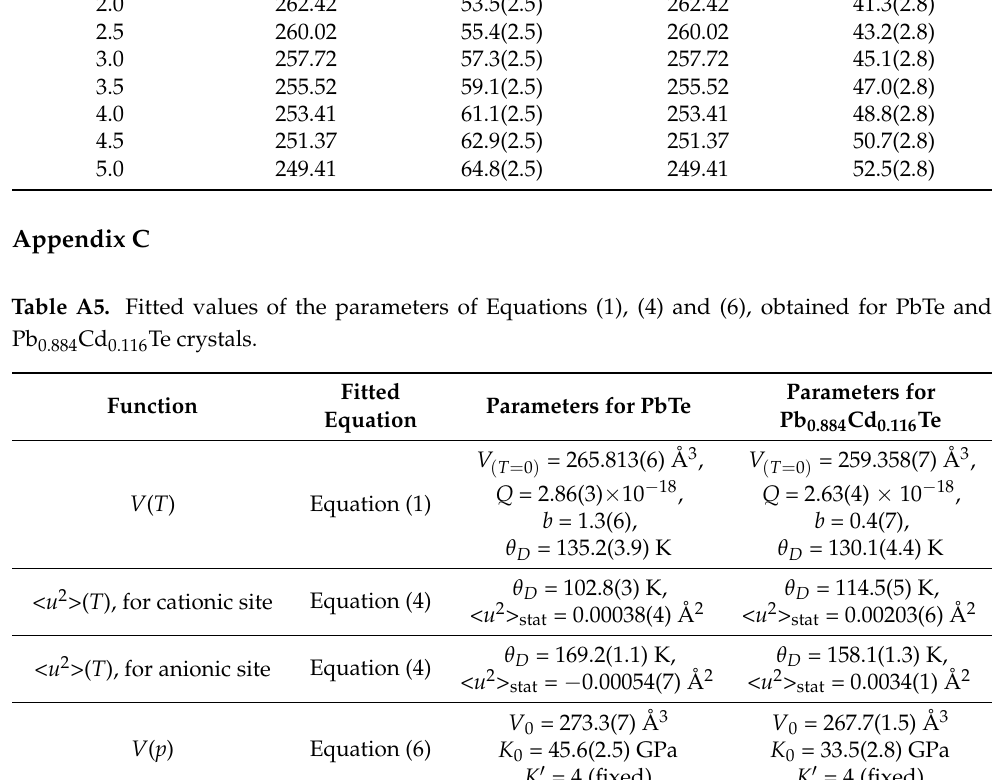
Table A6. Reported theoretical bulk modulus and its derivative for PbTe and Pb 1 − x Cd x Te, x =